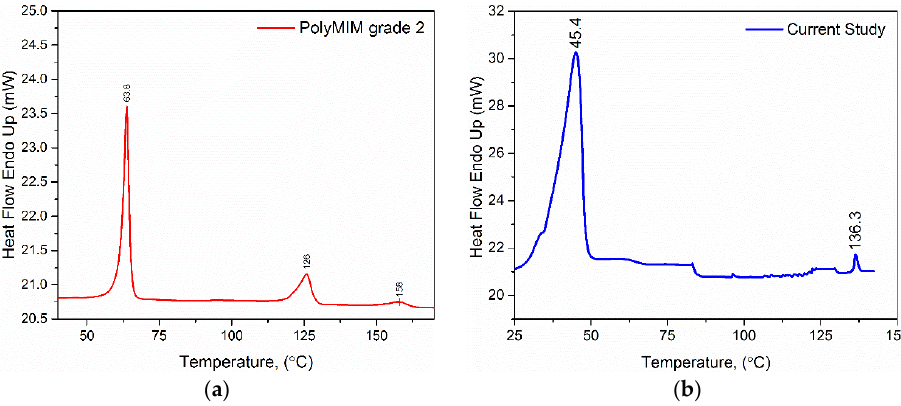
Figure 3. DSC thermograms for the ( a ) commercial feedstock and ( b ) current study feedstock.